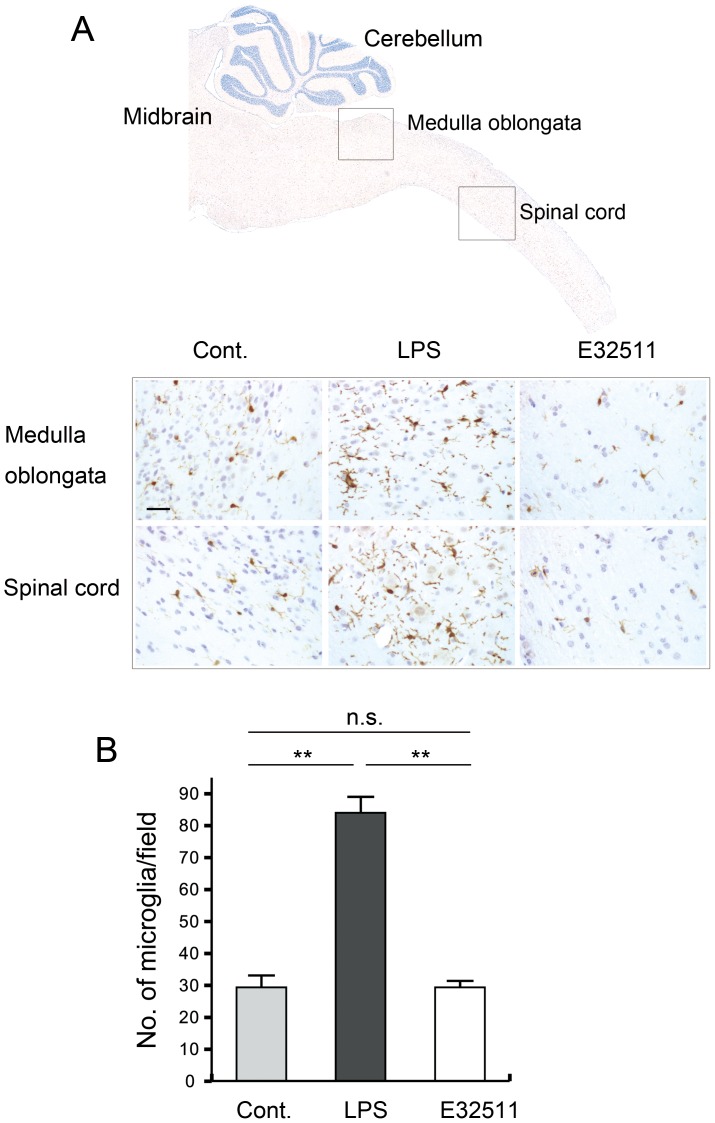
Microglial activation in i.p. LPS-injected and E32511 model mice.(A) Microglia in the medulla oblongata and the spinal cord were not activated in the control (uninfected) and E32511-infected mice, but were activated in i.p. LPS-injected mice. Scale bars: 2 µm. (B) The number of activated microglia significantly increased in the LPS-injected mice but not in the control and E32511-infected mice (LPS vs. control, p<0.0001; LPS vs. E32511, p<0.0001 and control vs. E32511, p = 1). Microglia were observed and counted manually from 5 non-overlapping fields. Statistical difference was measured by student's t test. **p<0.001.